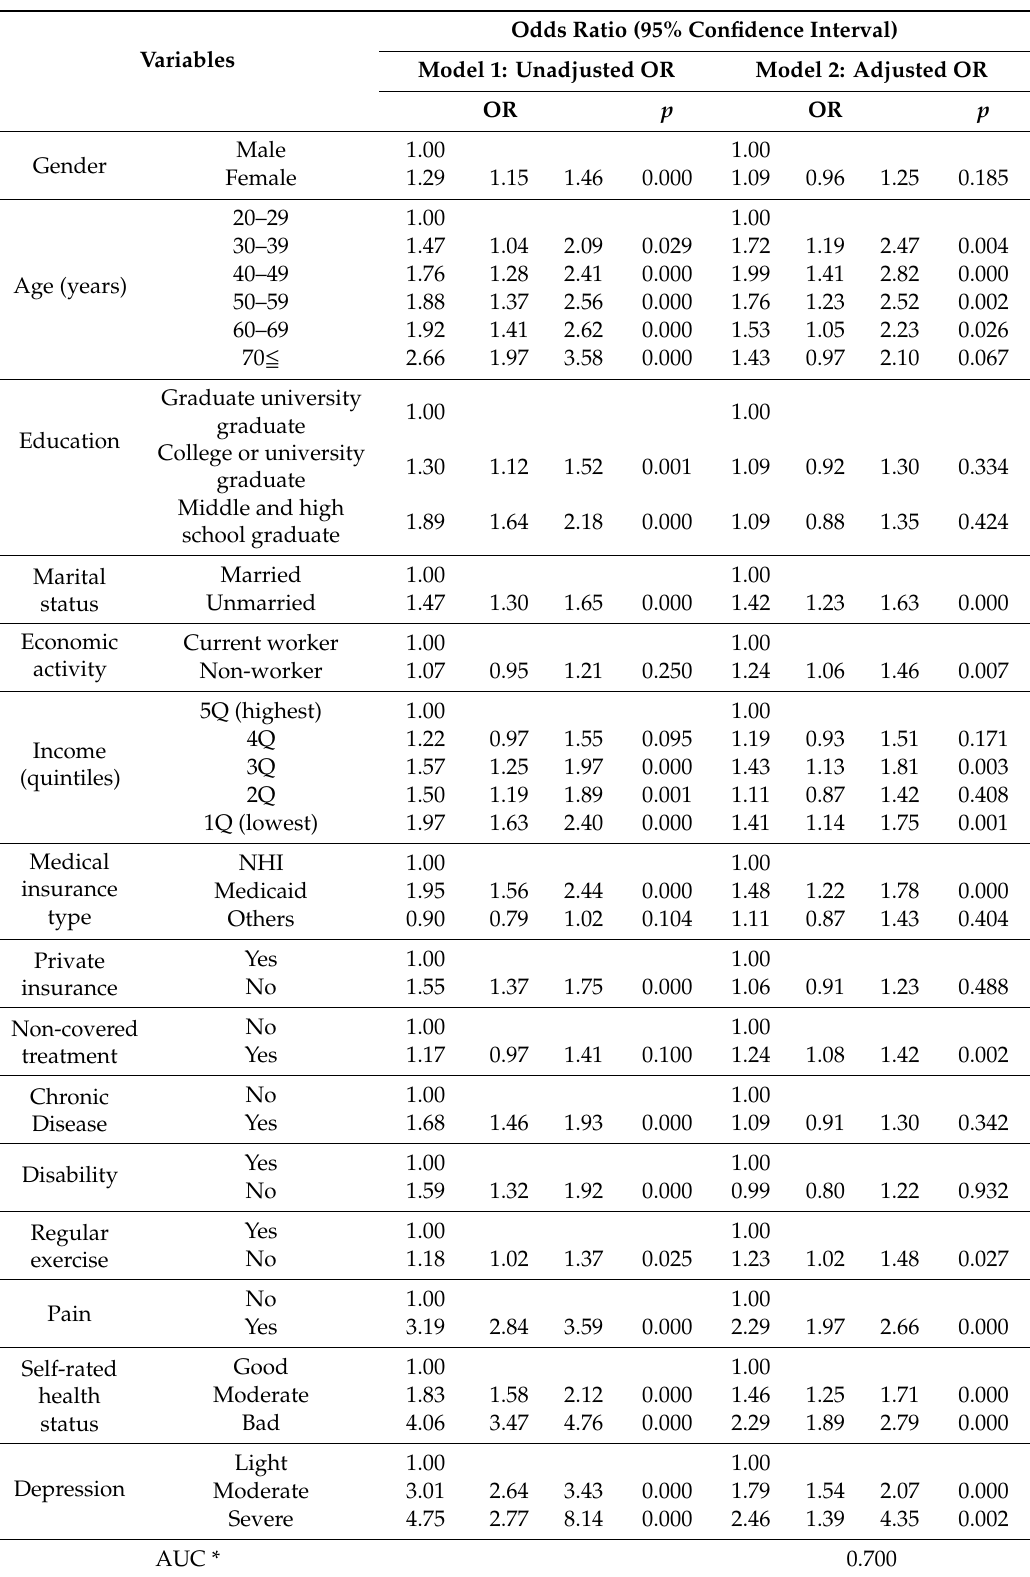
Table A3. Factors a ff ecting unmet